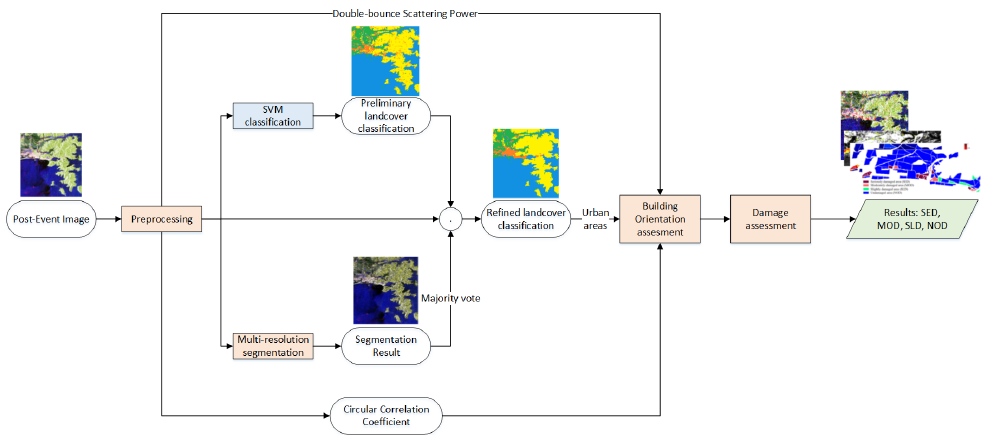
Figure 7. Flowchart of the proposed architecture proposed by Ji et al. The miniature images are from